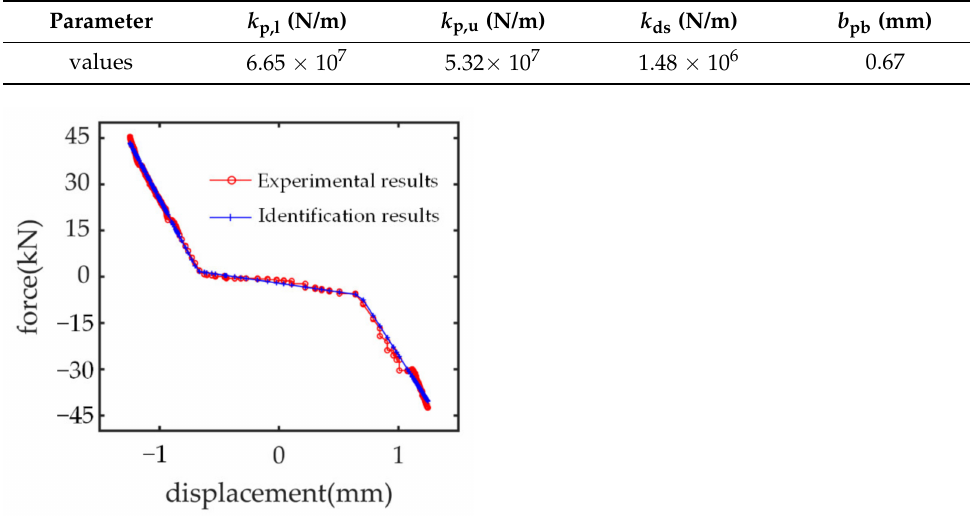
Figure 4. Stiffness identification with PSO